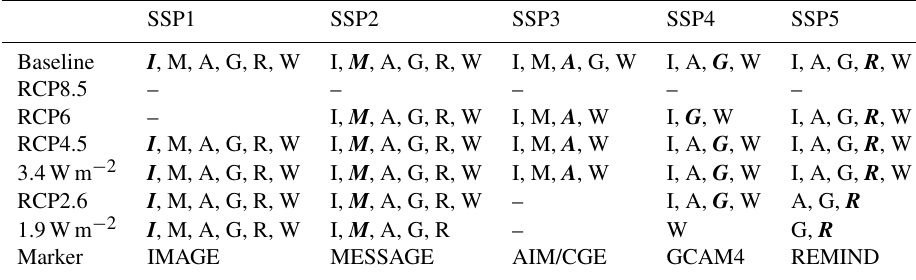
Table B1. SSP IAM implementations available in the SSPv2 database. Model names are abbreviated using the first character. Illustrative marker scenarios are marked by bold italic letters. There are no RCP8.5 scenario implementations, as no SSP IAM baseline shows forcing levels above